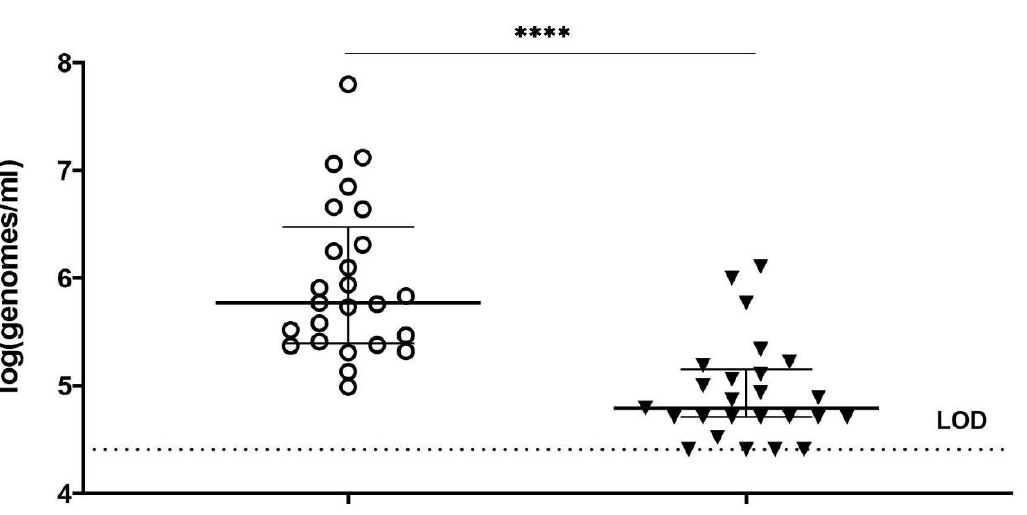
Figure 3. Reduction of cells log(genomes/mL) obtained with Gardnerella species-specific qPCRs for vaginal samples from women with BV, untreated (only MES buffer, transparent circles) and treated with 100 µg/mL PM-477 (black triangles) overnight. ****: p - value < 0.0001, as assessed by Wilcoxon test. LOD – limit of detection.